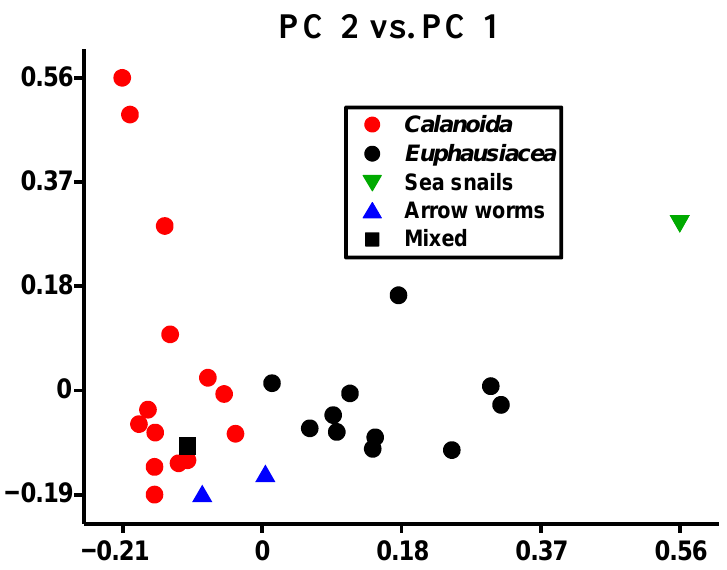
Figure 7. The best score graph for the ComDim – PCA decomposition.